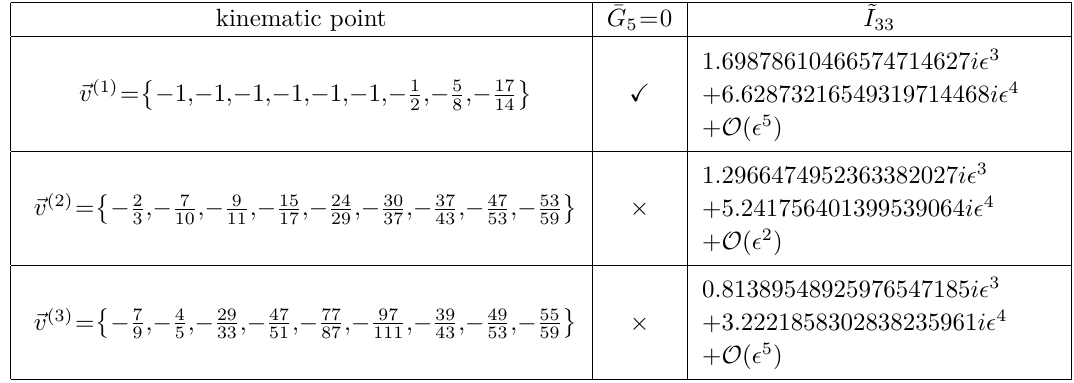
Table 1. Numerical evaluation of the hexagon integral at several kinematic points. The values correspond to the UT hexagon integral and are obtained using the one-fold integral